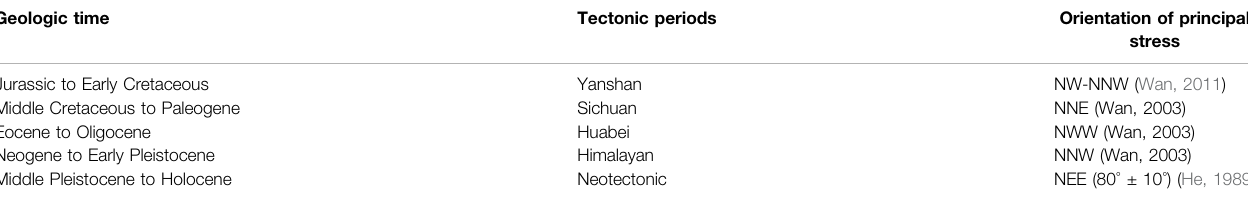
TABLE 1 | Tectonic stages and orientation of principal stress of the study area since Jurassic. Geologic time Tectonic periods